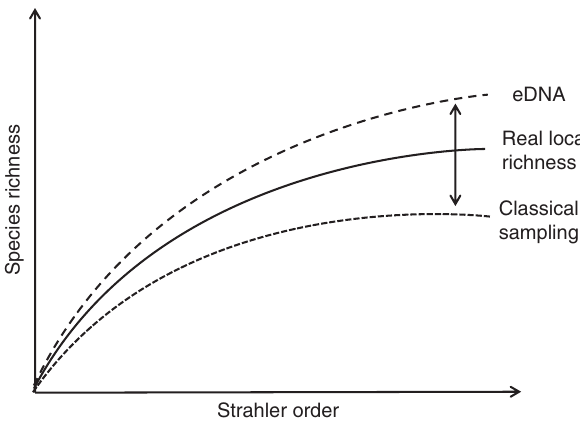
Figure 5 | Conceptual model of environmental DNA dynamics in a hypothetical river network. While classical sampling only detects a fraction of real local diversity due in part to spatial autocorrelation, eDNA sampling allows an estimate of catchment-level diversity, including both aquatic and terrestrial taxa, and integrates this information across space due to downstream transport of eDNA.